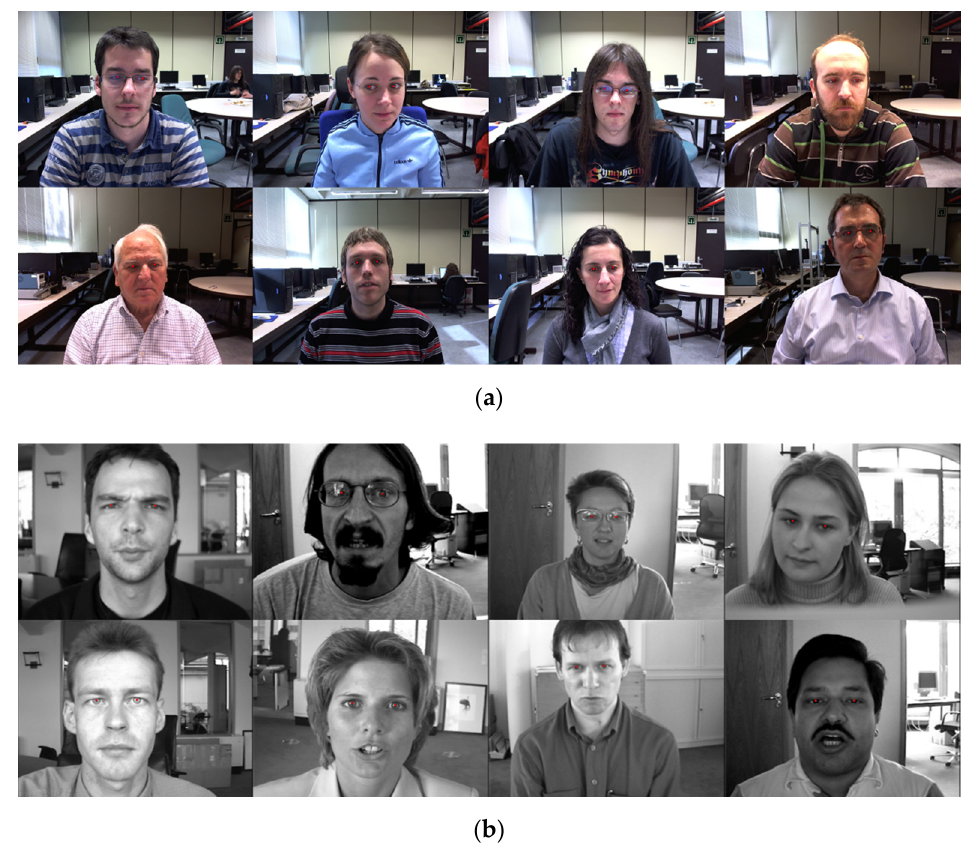
Figure 5. The results of detected and tracked of pupil center by applying the proposed lightweight CCD-R and consistency check to ( a ) GI4E and ( b ) BioID. CCD-R and consistency check to ( a ) GI4E and ( b )